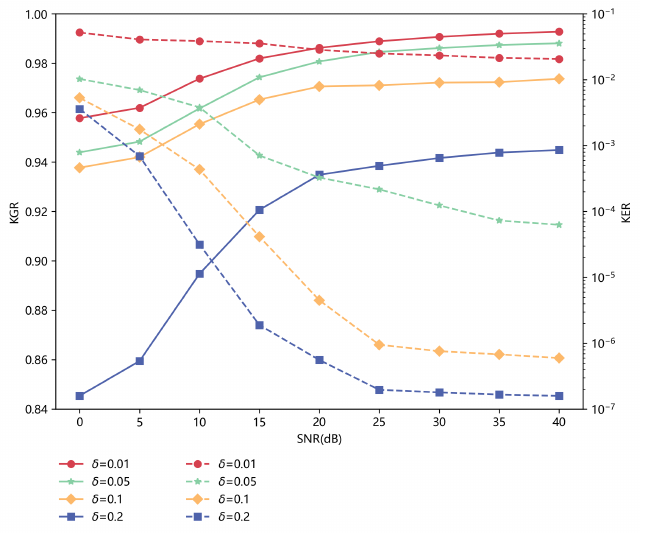
Figure 9. The KGR and KER of the initial key with different values of the quantization factor δ based on the IRS-CRNet versus SNR. The IRS-CRNet is trained with the training dataset with 99,550 sets of 0 dB. The solid line represents KGR, and the dashed line represents